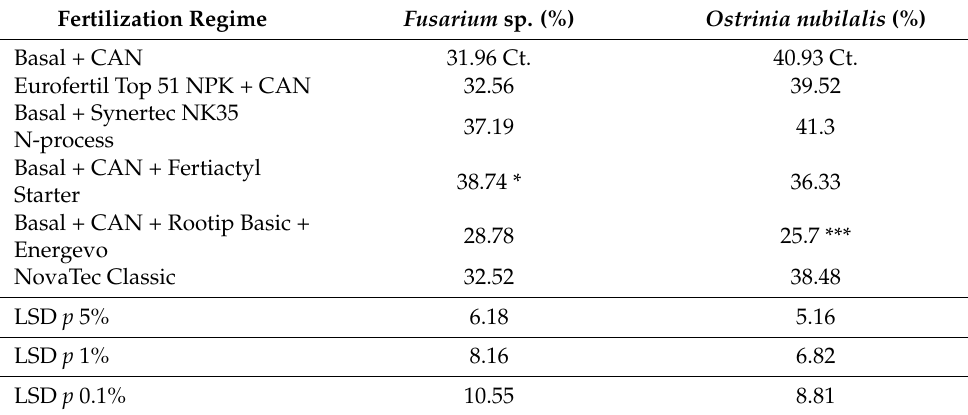
Table 5. Influence of fertilization regime on disease and pest incidence in maize. Fertilization